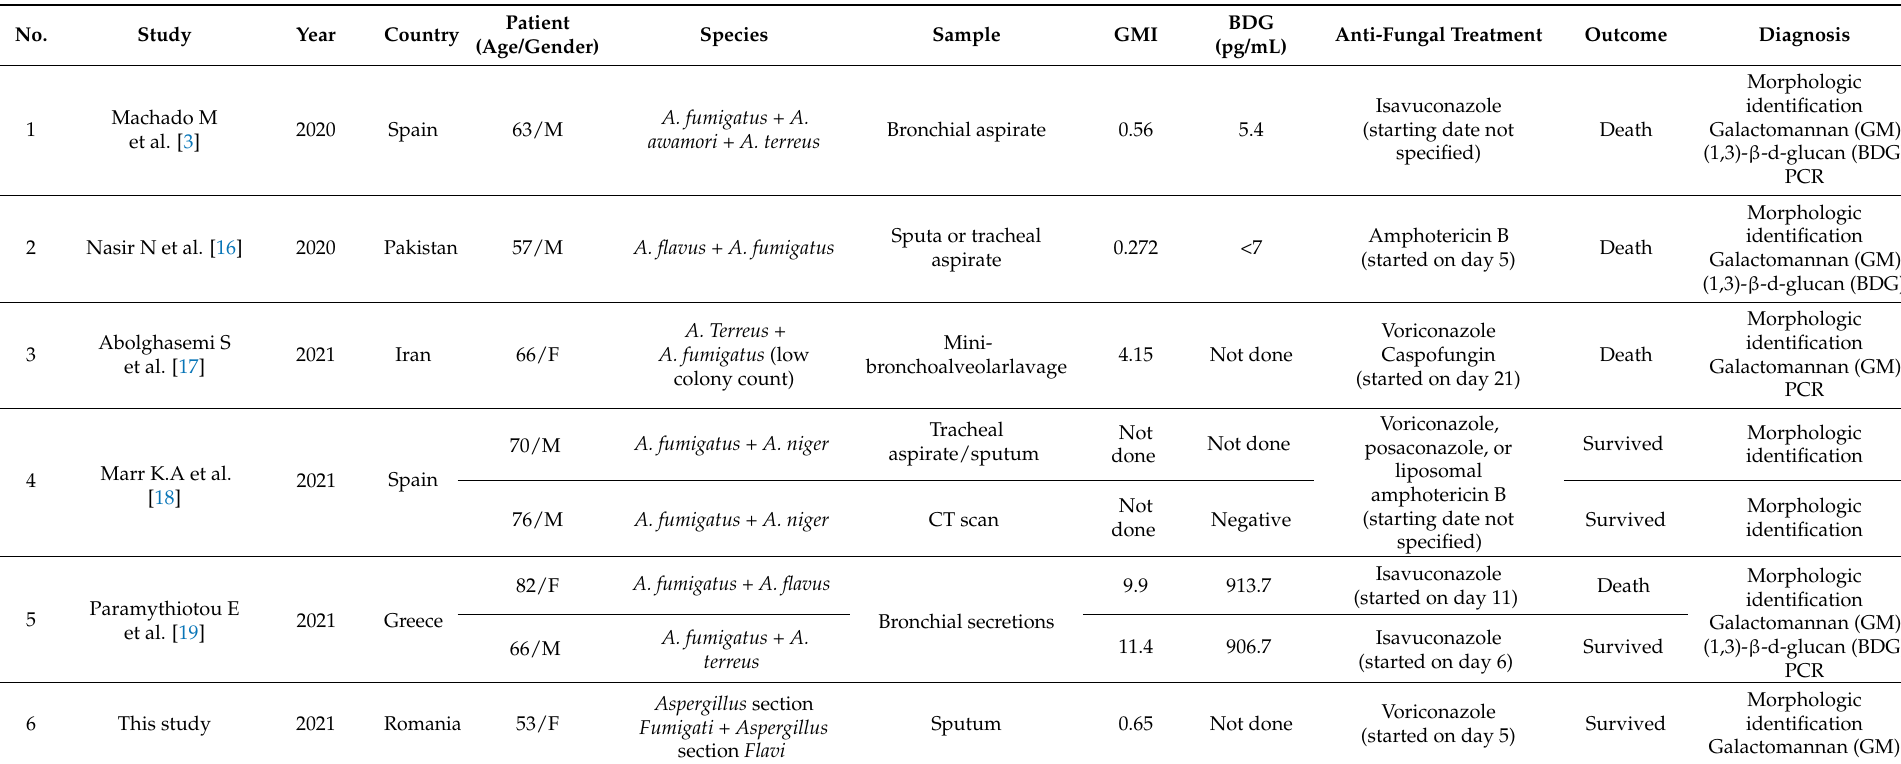
Table 3. Review of the existing case reports of COVID-19 associated pulmonary aspergillosis (CAPA) involving a mixed fungal